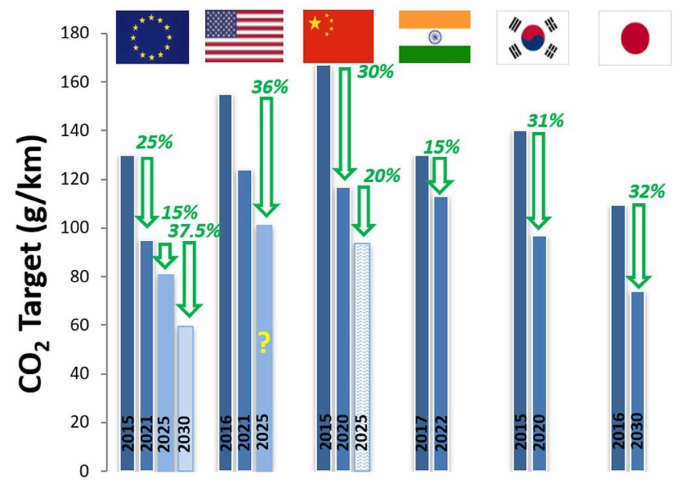
Figure 1. Summary of CO 2 targets for light-duty passenger cars in major markets. Reproduced with permission of reference